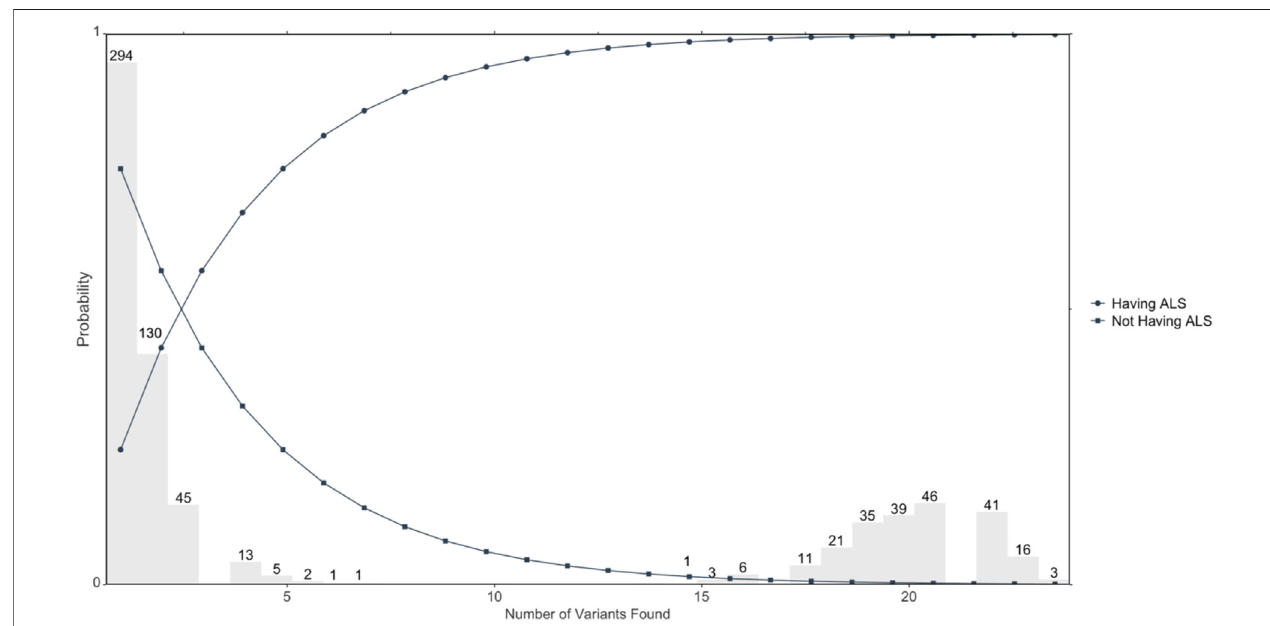
FIGURE 1 | Illustrates the probability of developing ALS based on the number of variants mutated. Circles represent the probability of developing ALS determined by the number of overall variants that are found; n = 713 ALS cases.